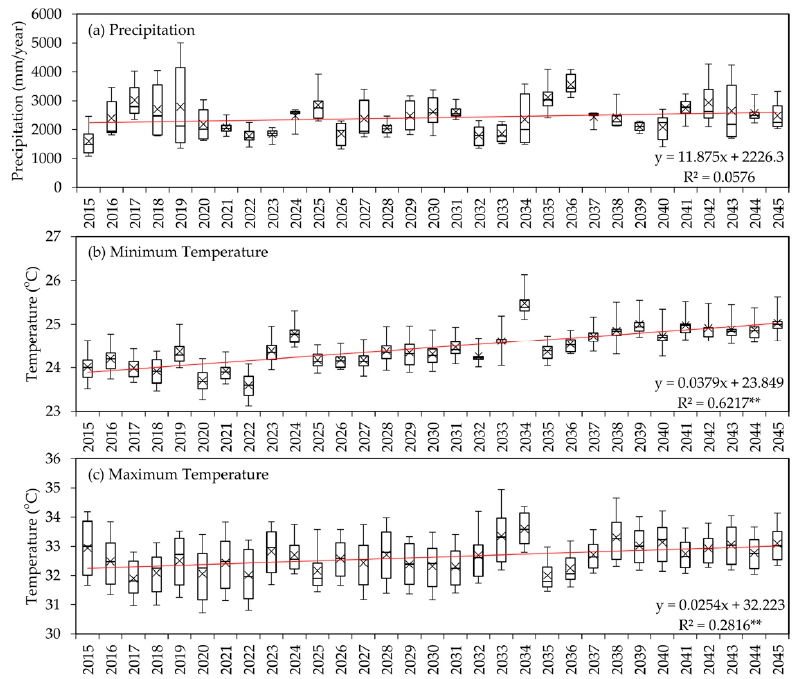
Figure 2. Projection of mean annual maximum and minimum temperatures and precipitation for all granary areas (2015–2045). Linear regression analyses show a significant trend (** p < 0.05).